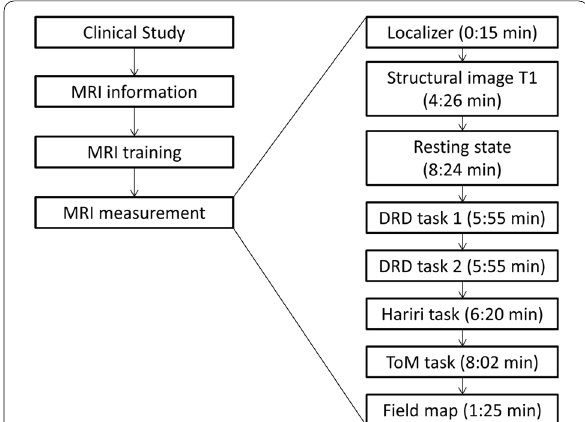
Fig. 1 Study overview. Left: After inclusion in the clinical studies A1, A2 and B2, respectively, subjects received the option to additionally participate in the MRI assessments (“MRI information”). If they were eligible and consented, they were introduced to each task outside the MR scanner (“MRI training”). Right: The MRI measurement consisted of a localizer scan, a structural T1-weighted image, a resting state fMRI sequence, three task-based fMRI paradigms (DRD task, “Hariri” task and ToM task) and a field map. The DRD task was